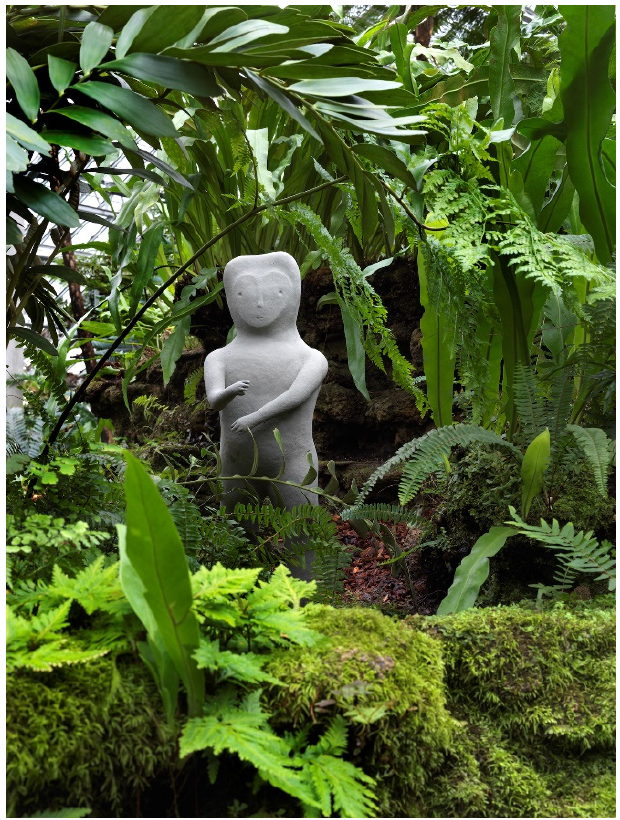
Figure 5. A Genius of the Spot V, 2020, glazed ceramic, 31 ″ × 9 ″ × 10 ″ . By design, art for the public garden leads back to the idea of ecological citizenship because of its ability to articulate a “further reaching philosophy” that gives us a critical perspective on our behaviors and thought systems. A sculpture placed in a garden begins to do the work of challenging some of the humanist dualisms that position art as separate from life and culture as divorced from nature. It shifts our focus away from those binaries, instead becoming a place where art, conservation, design, architecture, science, education, leisure, and play can come together. It offers the possibility of appreciating the nuance of difference and gives us a place where we can reclaim our roles as creators instead of consumers. Art and nature, especially when paired, make room for a silence that gives us some distance from the material. Maybe out of these quiet moments we will see that space is never really empty. We need less than we